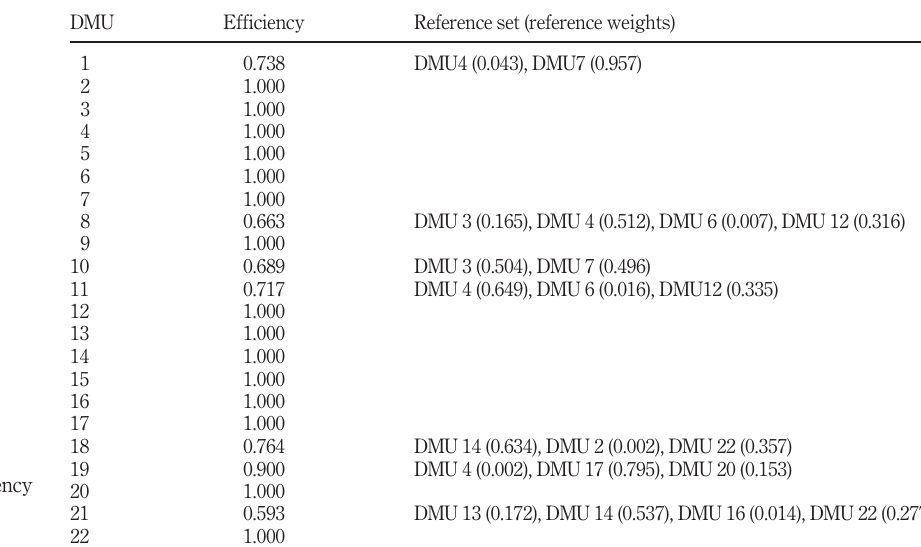
Table VI. Program ef fi ciency score and reference